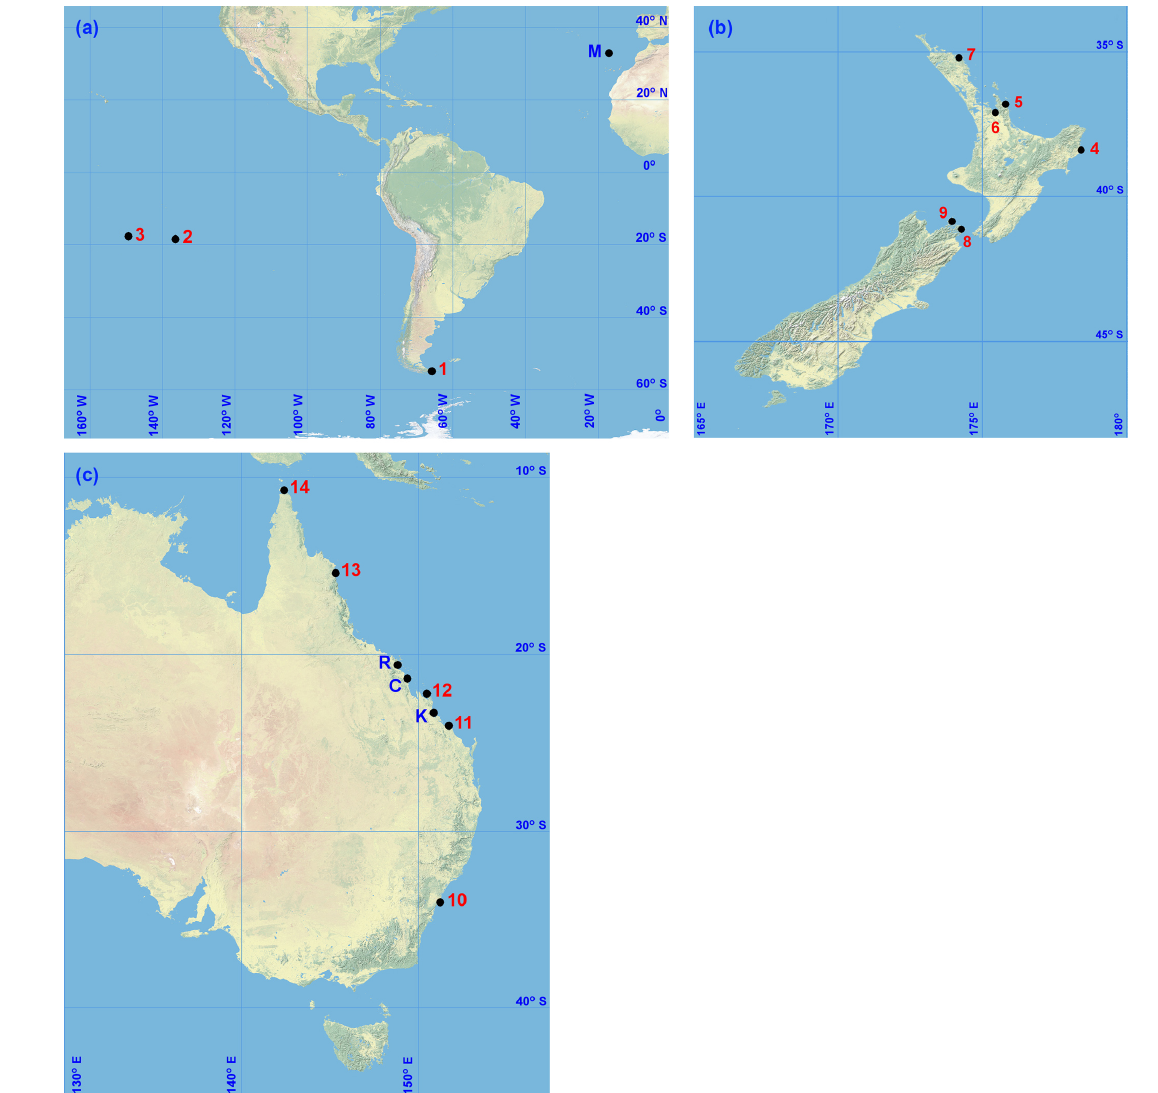
Figure 1. Locations of Cook’s tidal observations: (a) before New Zealand, (b) New Zealand and (c) Australia. Stations 1–14 are listed in Table 1 and stations M, K, C and R in Appendix B. Maps are made using Natural Earth free vector and raster map data (http://www.